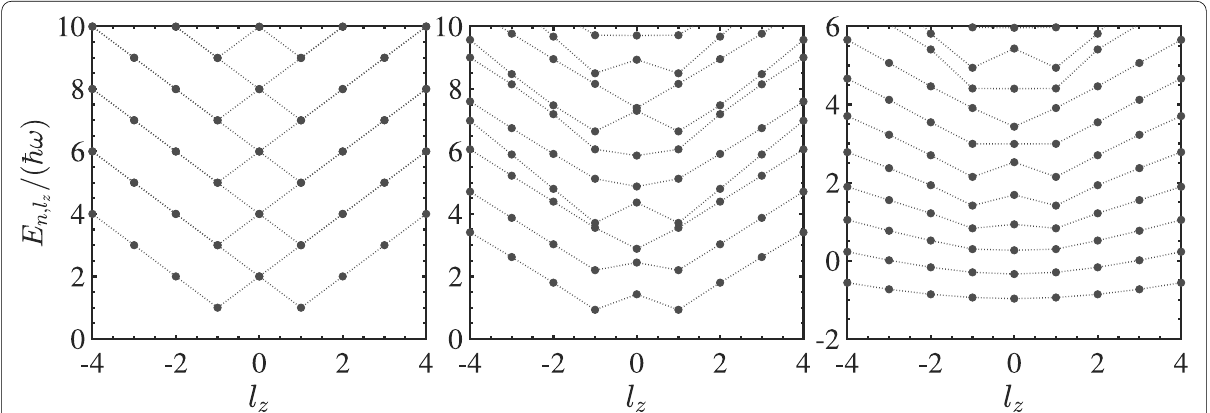
0 , 100 and 250 (left to right). The energy is characterized = 0 as =